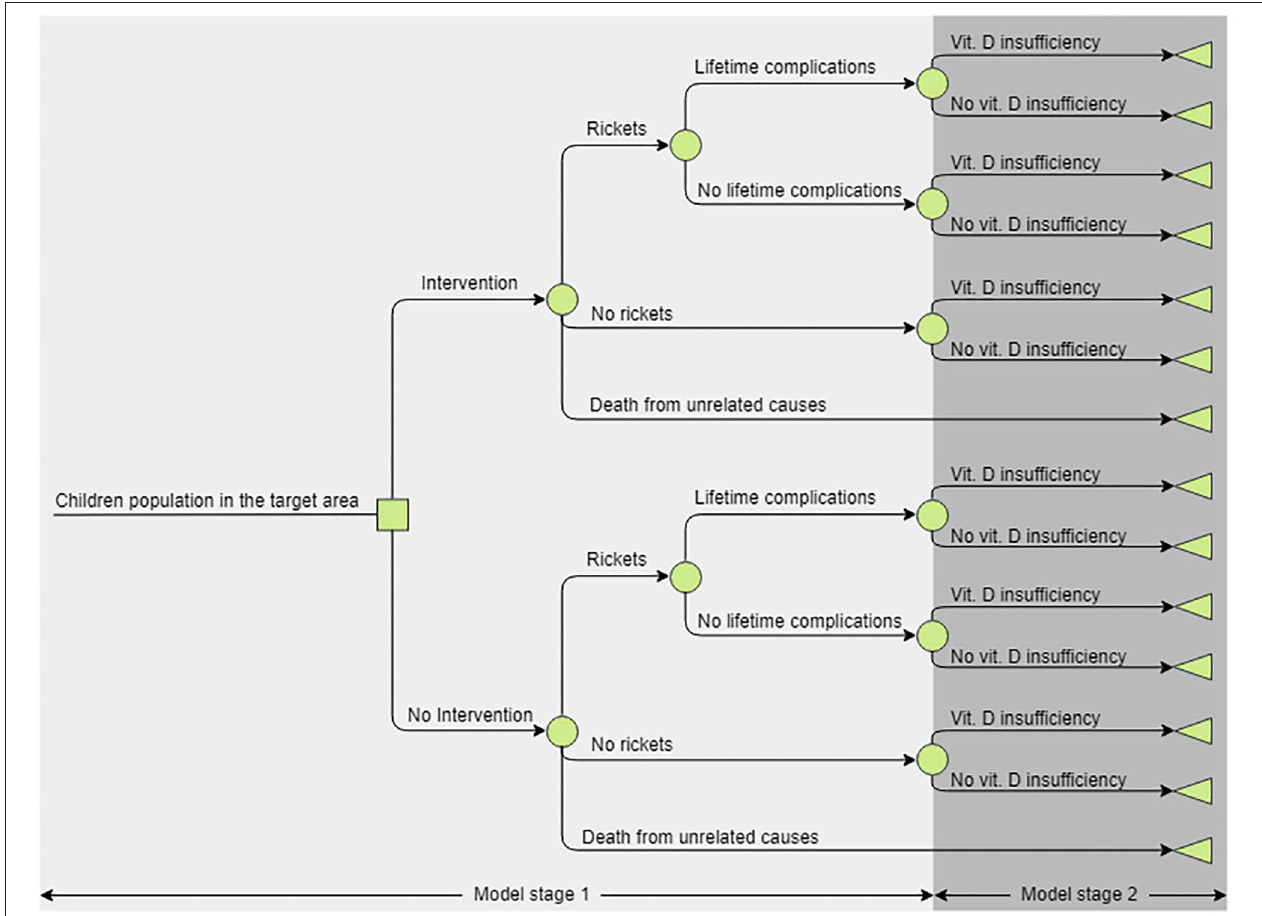
FIGURE 1 | The structure of the decision tree analytic model. The model consists of two arms—current and alternative practices. Stage 1 represents the first 4 years of life, if a child developed rickets they could recover completely or recover but experience lifelong complications, children could also die as a result of all-cause mortality. In Year 5 all alive children transition to stage 2, where they can be vitamin D deficient and in their latter life experience disutility and increased mortality risk, or not. Children would remain in the stage 2 for the remainder of their lifetime as the deficiency prevalence in the cohort is assumed to be